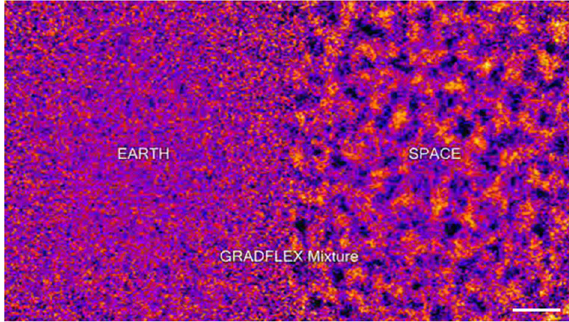
Fig. 1 Non-equilibrium concentration fl uctuations. False-colour shadowgraph images of non-equilibrium concentration fl uctuations induced by the Soret effect in a polystyrene polymer solution on Earth (left) and in space (right) during the GRADFLEX experiment on FOTON M3 3 . Scale bar: 2.0